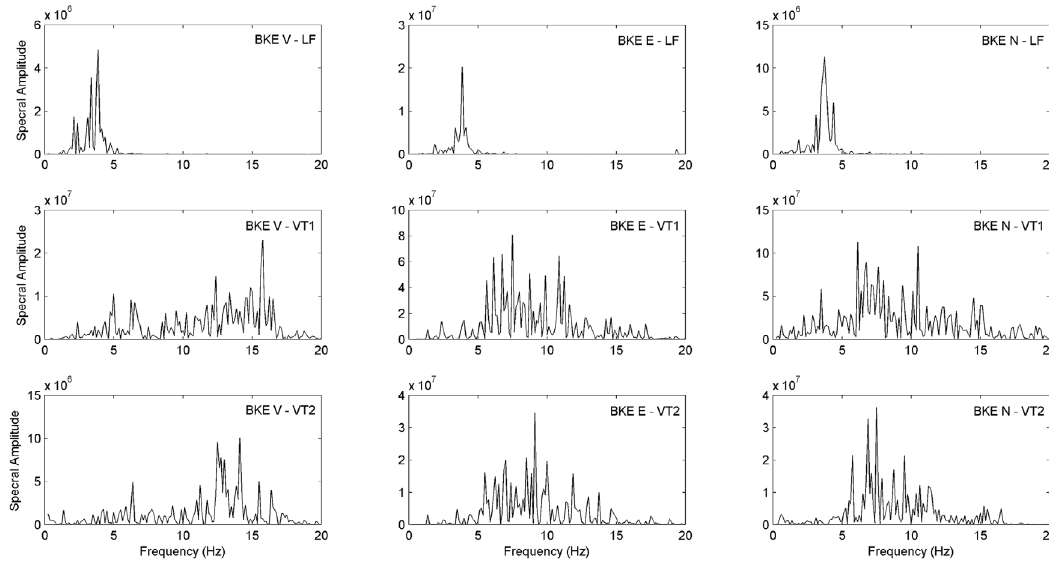
Figure 4. Spectral amplitudes vs frequency for the three analyzed events at BKE station. In the upper-right corner of each panel the event and the ground motion component are